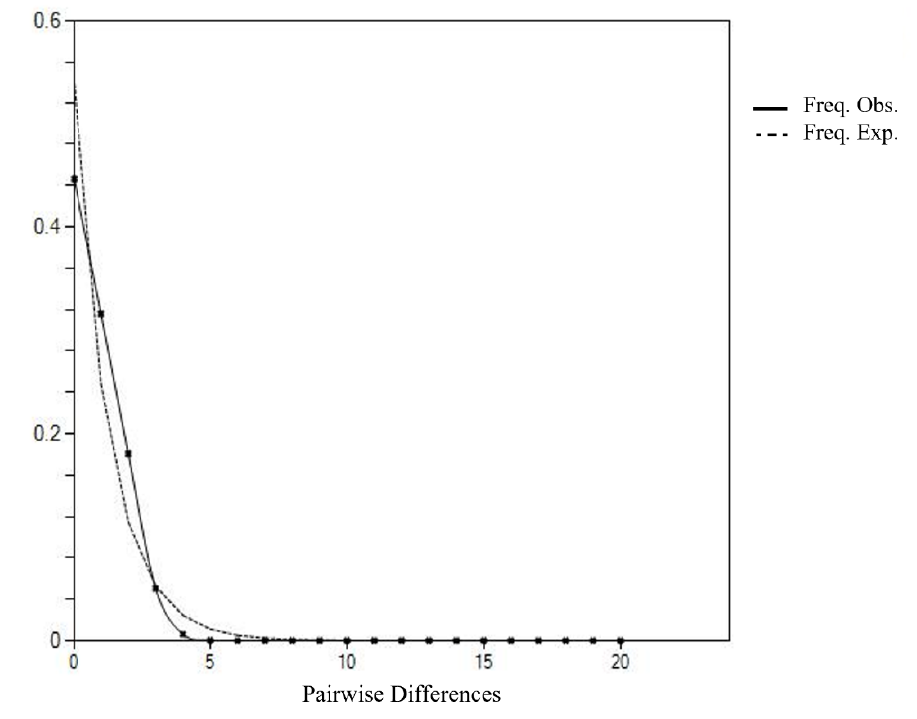
Figure 2. Frequencies of the observed and expected mismatch distribution in M. vitrata populations of India. X-axis (x), number of pairwise nucleotide differences; Y-axis (y), frequency of mismatches; Freq. Exp., frequency expected (dashed line); and Freq. Obs, frequency observed (solid line). Table 3. Analysis of molecular variance (AMOVA) for the COI sequences of different M. vitrata populations.